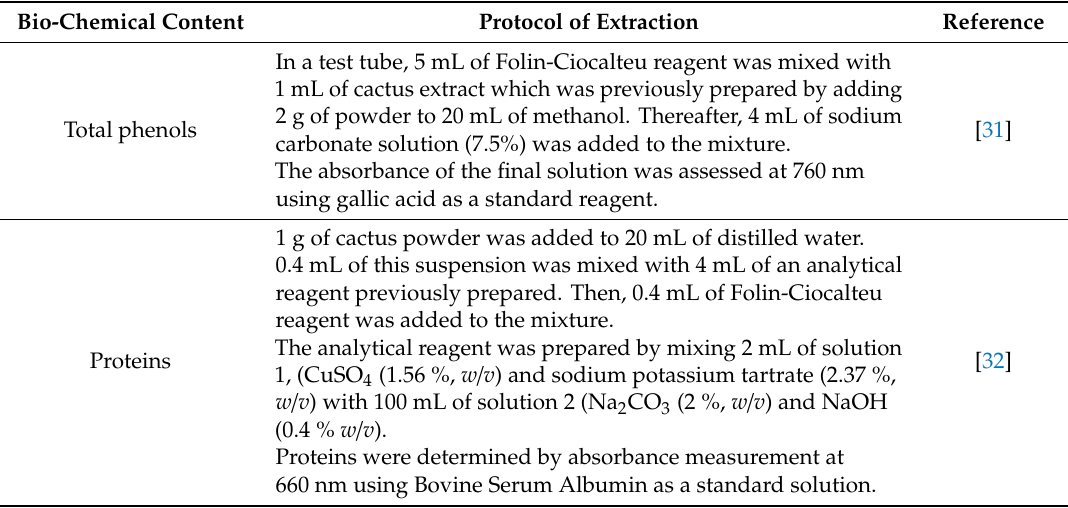
Table 1. Analytical methods for bio-chemical components extraction and quantification.